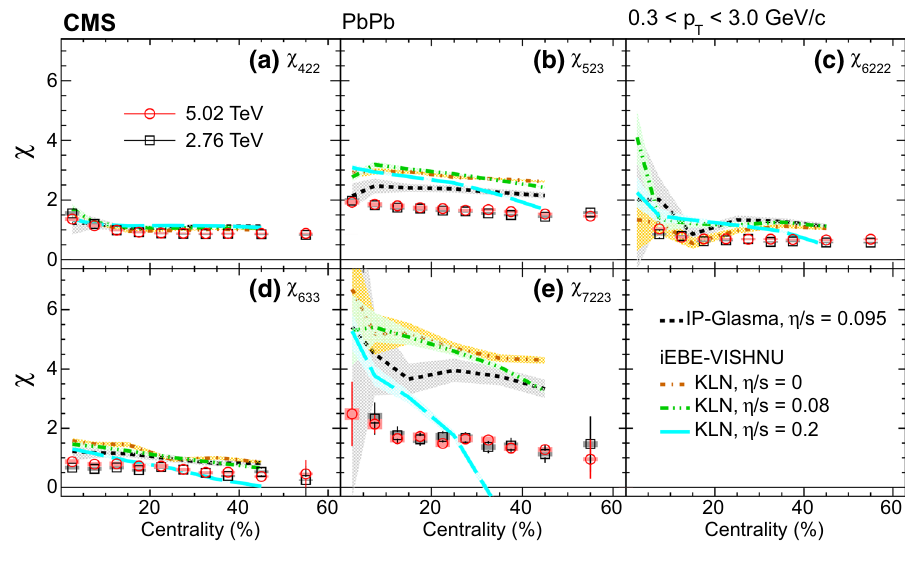
Fig. 6 The same results as in Fig. 5 but compared with predictions from a hydrodynamics + hadronic cascade hybrid approach with the IP-Glasma initial conditions using η/ s = 0 . 095 [50] at √ = 5 . 02TeV and from s NN iEBE-VISHNU hydrodynamics with the KLN initial conditions using η/ s = 0, 0.08 (the same curve as in Fig. 5) and 0.2 [28] √ = 2 . s at NN